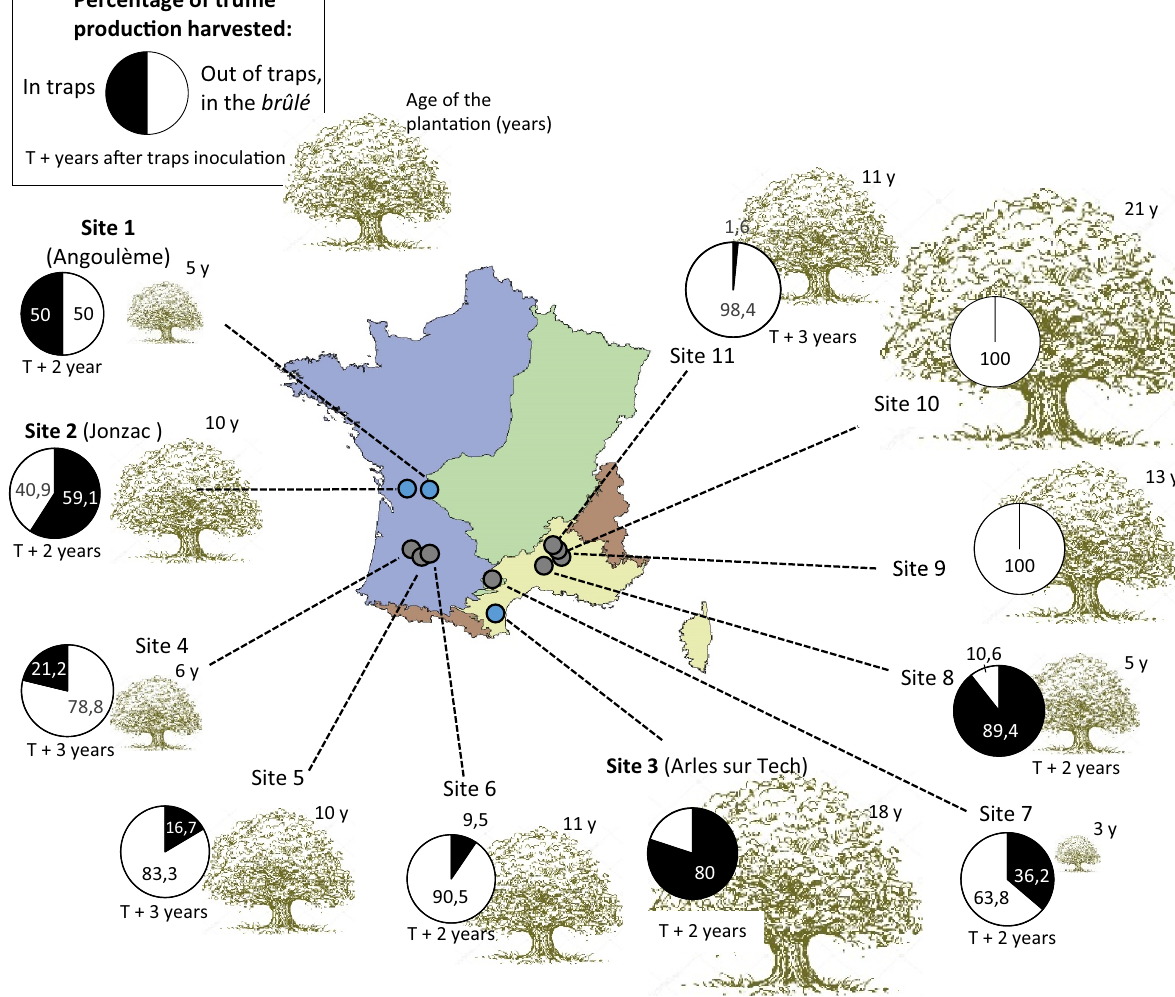
Figure 2. Geographical distribution of the study sites, with indication of the proportion of truffle biomass harvested inside truffle traps (in black) and in the surrounding brûlés (in white), expressed in percentage. Numbers in tree symbols indicate tree age (top, which is also reflected by the size of the tree) and the number of years needed to gather the first truffles in truffle traps (bottom). Colors in the map indicate French climatic domains as follows: yellow: Mediterranean, blue: Oceanic, green: continental and brown: mountain, from Noirfalise, A.. Map of the Natural Vegetation of the Member Countries of the European Community and the Council of Europe: Scale 1: 3.000. 000 (Vol. 10,970). Office for Official Publications of the European Communities (1987). Map freely accessible at https:// inpn. mnhn. p -value = 0.59 by likelihood ratio test) in the inoculated traps than in the non-inoculated control traps . No differ- ence was apparent between traps inoculated with one versus two mating types (in particular, no higher density with two mating types). The fruitbody density was fourty-eight fold higher in the non-inoculated control traps than in surrounding brûlés ( p -value < 1e-4 by likelihood ratio test; Table S3). The concentration of T. melanosporum mycelium in soil varied significantly across sites with mycelium at Site 2 (Jonzac) being less concentrated than the two others (Table 1). There was no significant difference in mycelium concentration between control traps and inoculated traps ( p -value = 0.08 by likelihood ratio test). Genetic structure of fruitbody populations in truffle traps. Overall, the MLGs analysis of 58 mater- nal genotypes revealed 36 different MLGs (Table 2). Three of them were represented by more than two fruitbod- ies, leading to a clonal diversity of 0.61. Contrastingly, the MLG analysis of 49 paternal genotypes revealed 49 distinctive MLGs (Table 2), i.e. a clonal diversity of 1. On each host tree included in the experiment, multiple maternal MLGs were identified, in both non-inoc- ulated and inoculated traps. On six of the ten trees included in the experiment, and within 11 of the 22 traps containing truffles at harvest date, maternal MLGs of the two mating types were detected (see Figure S2 for an example from Site 2). Under each of the three host trees presenting more than 10 fruitbodies (Table S2), two